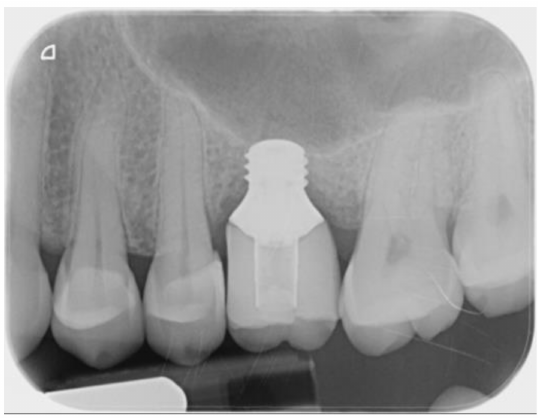
Figure 7. Radiological view at the end of